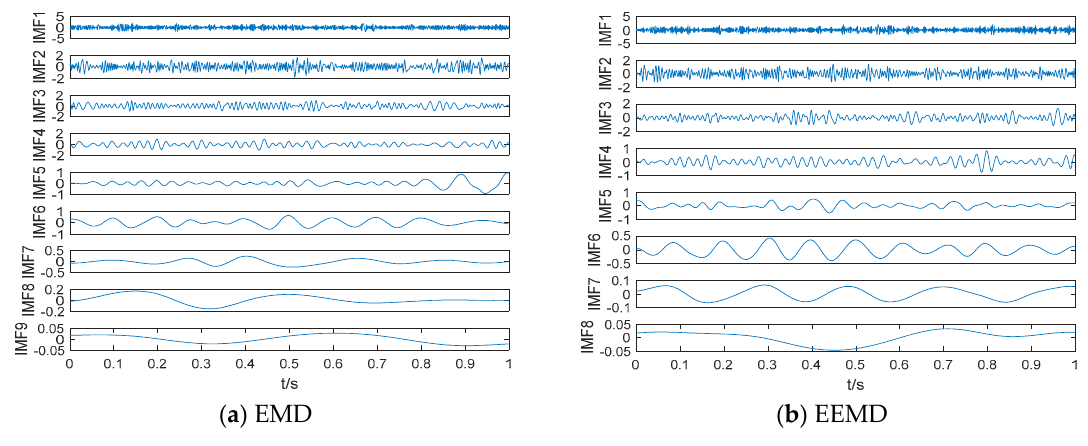
Table 4. The KPE distribution of IMF7 under different driving force frequencies.